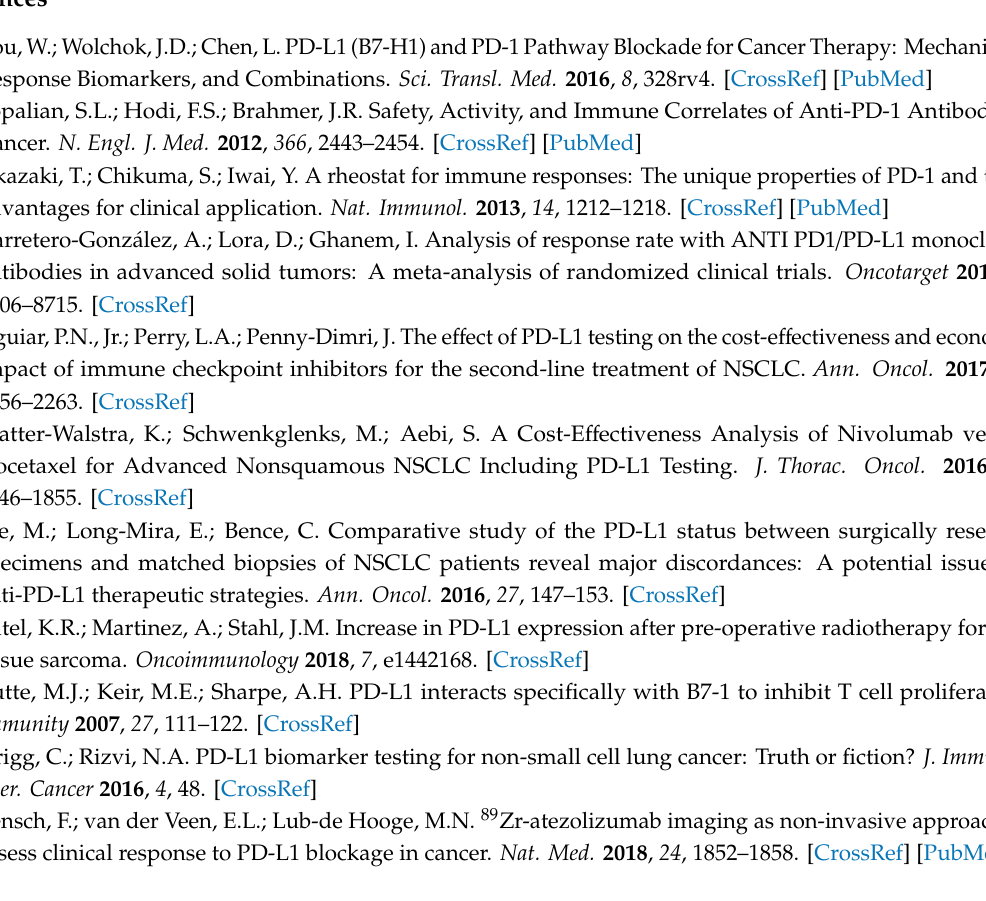
Figure S1: Structure of GGGYK-NHCS-Bn-NOTA, Figure S2: SEC analysis of the functionalized Nbs, Figure S3: SDS-PAGE and WB analysis, Figure S4: Mass determination analysis, Figure S5: Radio-SEC analysis of metabolites for the site-specifically radiolabeled compound in blood and urine. Figure S6: Radio-SEC analysis of metabolites for the randomly radiolabeled compound in blood and urine. Figure S7: Ex vivo assessment of hPD-L1 expression by FACS. Table S1: Ex vivo biodistribution of the 68 Ga-labeled NOTA-Nbs in C57BL / 6 mice. Table S2: Preliminary data used for the statistical analysis: biodistribution and in vivo tumor targeting in athymic nude mice bearing hPD-L1 POS or hPD-L1 NEG tumors, Table S3: Comparative study of tumor uptake between the site-specifically and randomly 68 Ga-labeled